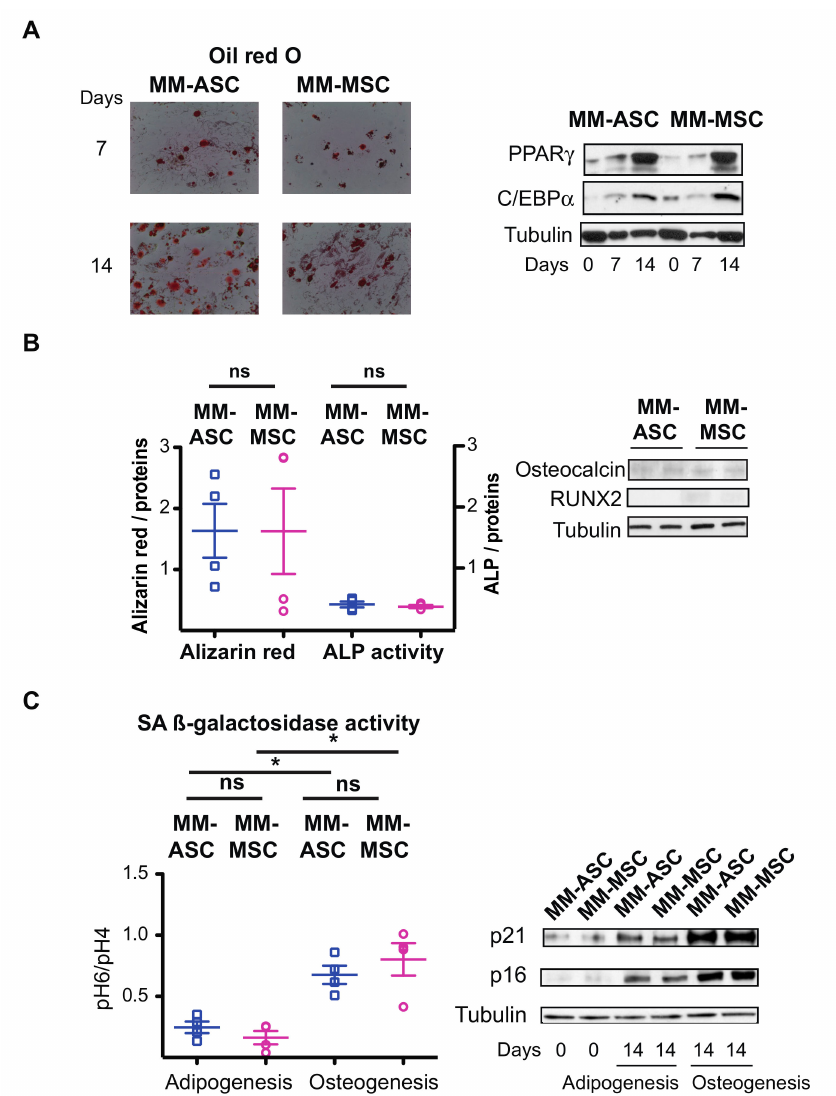
Figure 5. Comparison of ASC and MSC derived from the same MM patients. ( A ) MM-ASC and MM-MSC from the same patients were di ff erentiated into adipocytes for 7 or 14 days. The cells were stained with Oil-red-O to visualize lipid droplets and representative micrographs and scans are shown (left). Whole cell lysates were extracted on day 0, 7, or 14 of di ff erentiation and analyzed by immunoblotting. Representative immunoblots of PPAR γ , C / EBP α , and tubulin (loading control) are shown (left). ( B ) MM-ASC (blue) and MM-MSC (pink) were di ff erentiated into osteoblasts for 14 days. The cells were stained with Alizarin Red to visualize calcium deposition and ALP activity was assessed. ns, not significant (left). Whole cell lysates were extracted and analyzed by immunoblotting. Representative immunoblots of osteocalcin, RUNX2, and tubulin (loading control) are shown (right). ( C ) MM-ASC (blue) and MM-MSC (pink) were di ff erentiated into adipocytes or osteoblasts for 14 days as indicated. SA- β -galactosidase activity was assessed according to the ratio of pH 6- to pH 4-positive staining after 14 days of di ff erentiation. * p < 0.05, adipocyte vs. osteoblast. ns, not significant (left). Whole cell lysates were extracted from MM-ASC and MM-MSC on day 0 or 14 of adipocyte or osteoblast di ff erentiation and analyzed by immunoblotting. Representative immunoblots of cell cycle inhibitors p21, p16, and tubulin (loading control) are shown